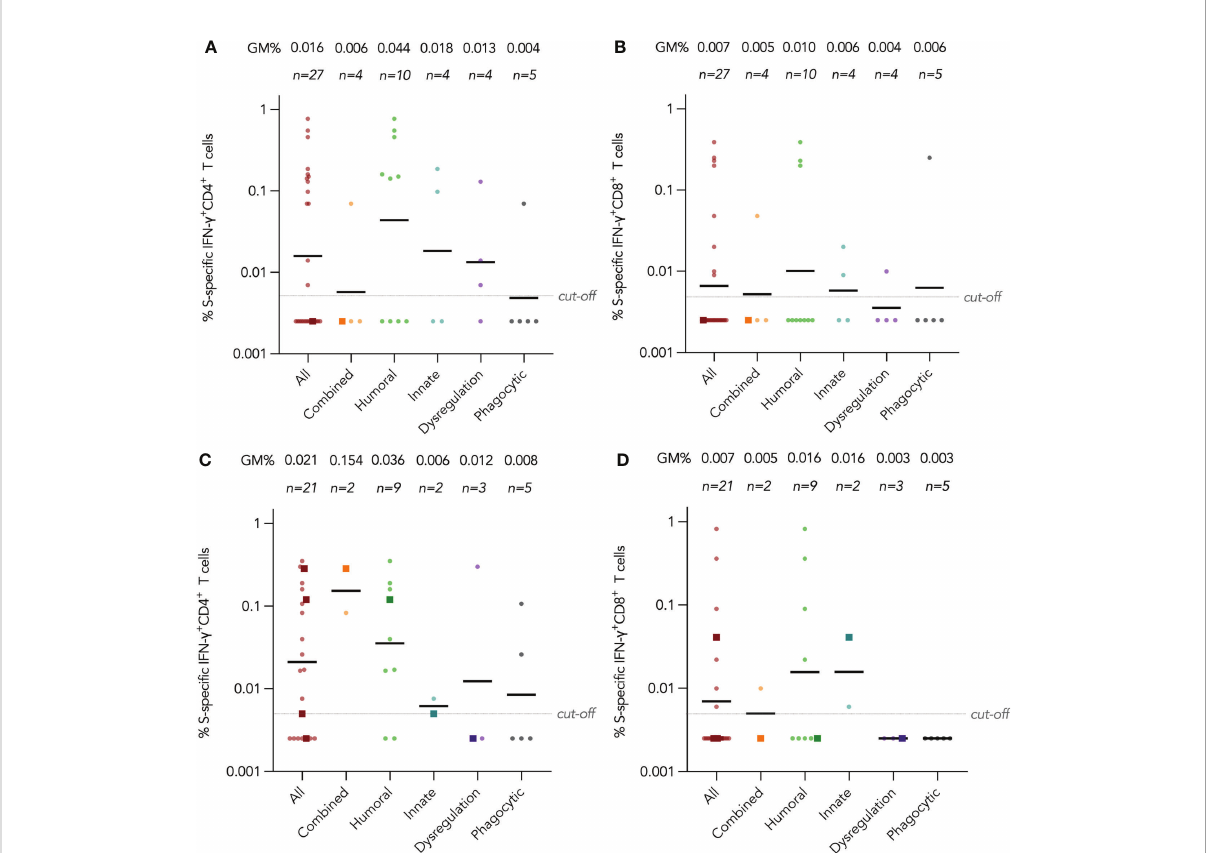
FIGURE 3 Wild-type (WT) S peptide pool-speci fi c interferon- g (IFN- g ) + CD4 + and CD8 + T cells after COVID-19 vaccination by disease category. (A) and (B) show S-speci fi c IFN- g + CD4 + and CD8 + results respectively in fi ve disease categories (combined, humoral, innate, dysregulation and phagocytic) after 2 doses, while C and D show S-speci fi c IFN- g + CD4 + and CD8 + results after 3 doses. Geometric means (GM) are shown with center lines and stated above each column. Cut-offs were drawn as grey lines. Number of analyzed available samples (n) are also stated above each column. A and B included 1 patient (in combined) who received fi rst 2 doses intradermally and their datapoints were shown as darkened squares. (C) and (D) also included 4 patients (1 each in combined, humoral, innate and dysregulation) who received their third dose intradermally and their datapoints were also shown as darkened